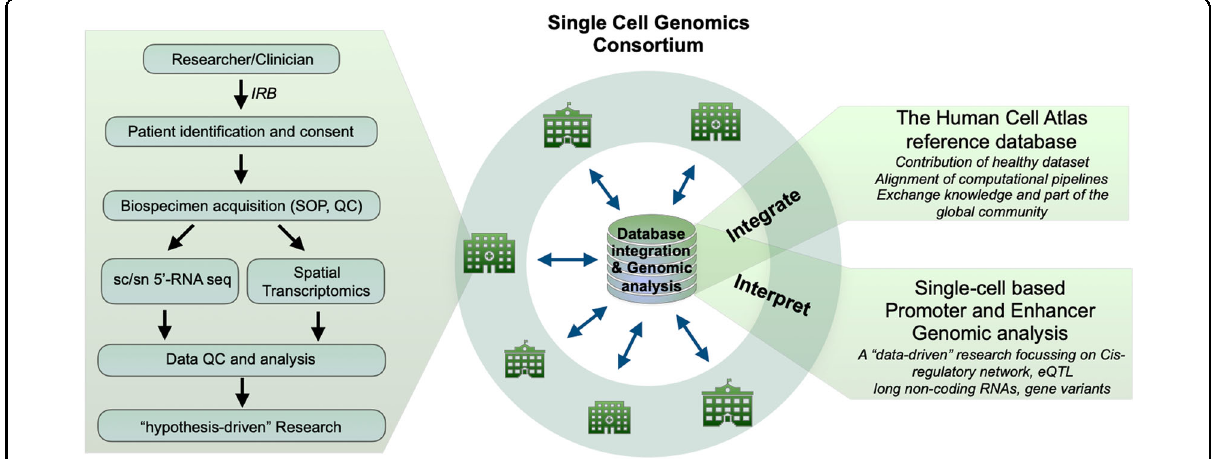
Fig. 1 A model of single cell medical network (SC_MED) consortium. A systematic work fl ow to facilitate each collaborating partner through IRB, sample acquisition, technology pro fi lling and data analysis to realize publication. In parallel, seamless integration of data from all collabarators to contribute healthy samples to the human cells atlas database. Genomics analysis based on 5-based technology to inter Cis-gene regulatory network across the human